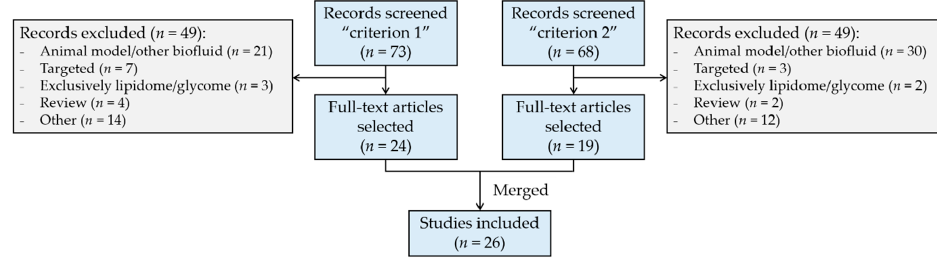
Figure 1. Flow diagram of literature selection and review process. Search “criterion 1”: term (“human milk” OR “breast milk”), AND “metabolom*”, AND “infant”; only articles. Search “criterion 2”: term (“human milk” OR “breast milk”), AND “metabolom*”, AND (“GC” OR “LC” OR “NMR” OR “CE”); only articles. Web of Science database was employed for literature